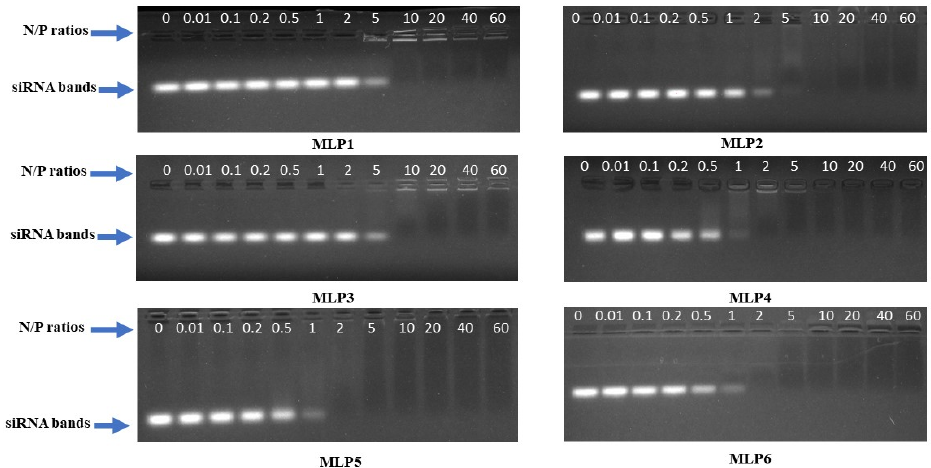
Figure 2. Agarose gel images of the gel retardation assay for the peptides/siRNA complex at different N/P ratios: peptide/scrambled siRNA complexes were formed with different N/P ratios (ranging from 0.01 to 60, in triplicates) to visually confirm the results of the binding affinity experiment using the SYBR green